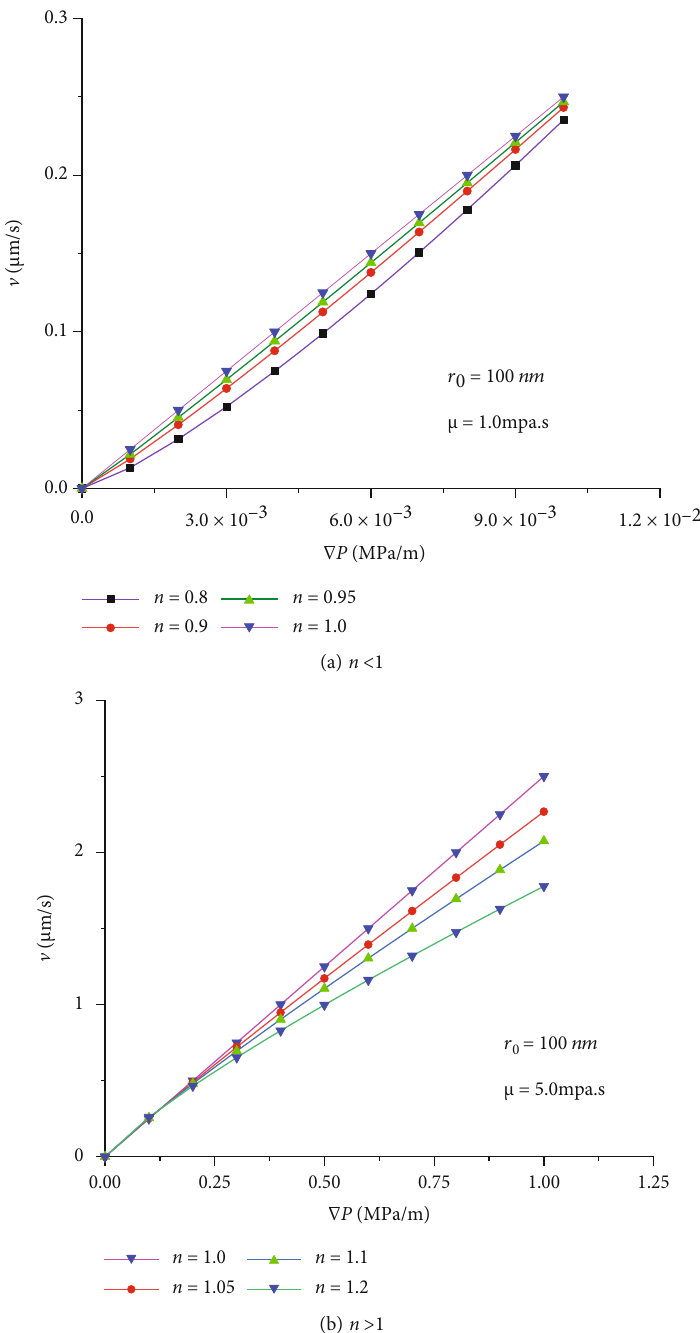
Figure 3: Relationship between liquid pressure gradient and fl ow velocity in micro-nanocircular